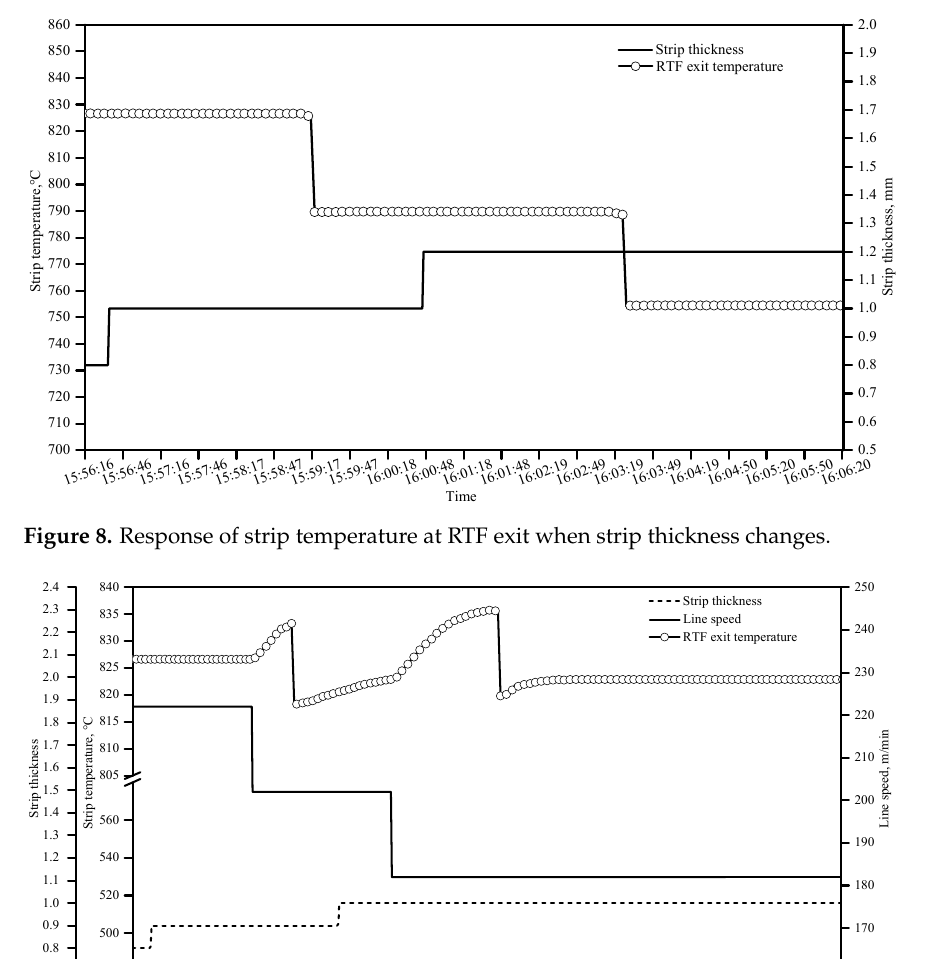
Figure 7. Response of strip temperature at RTF exit when line speed changes.